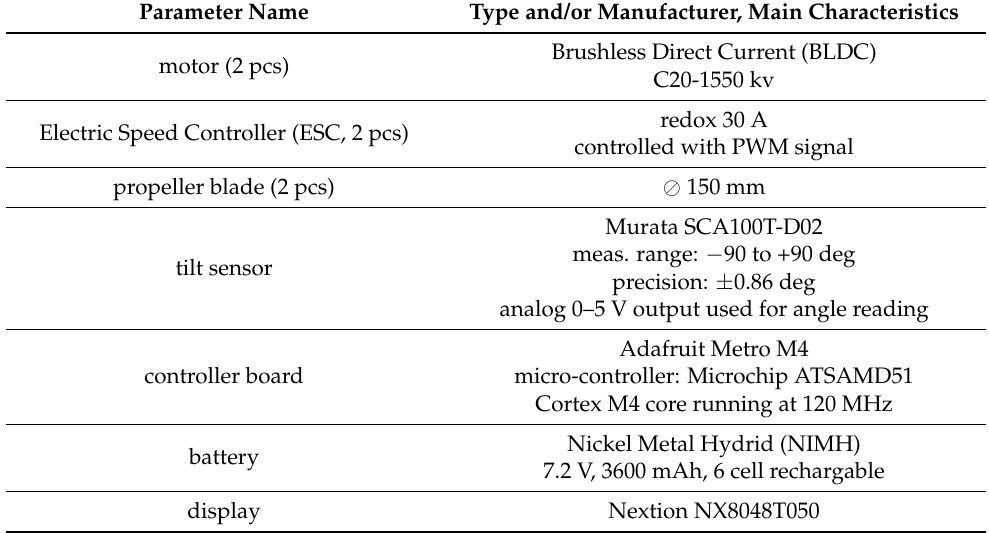
Table 1. Information about the main bi-rotor test bed